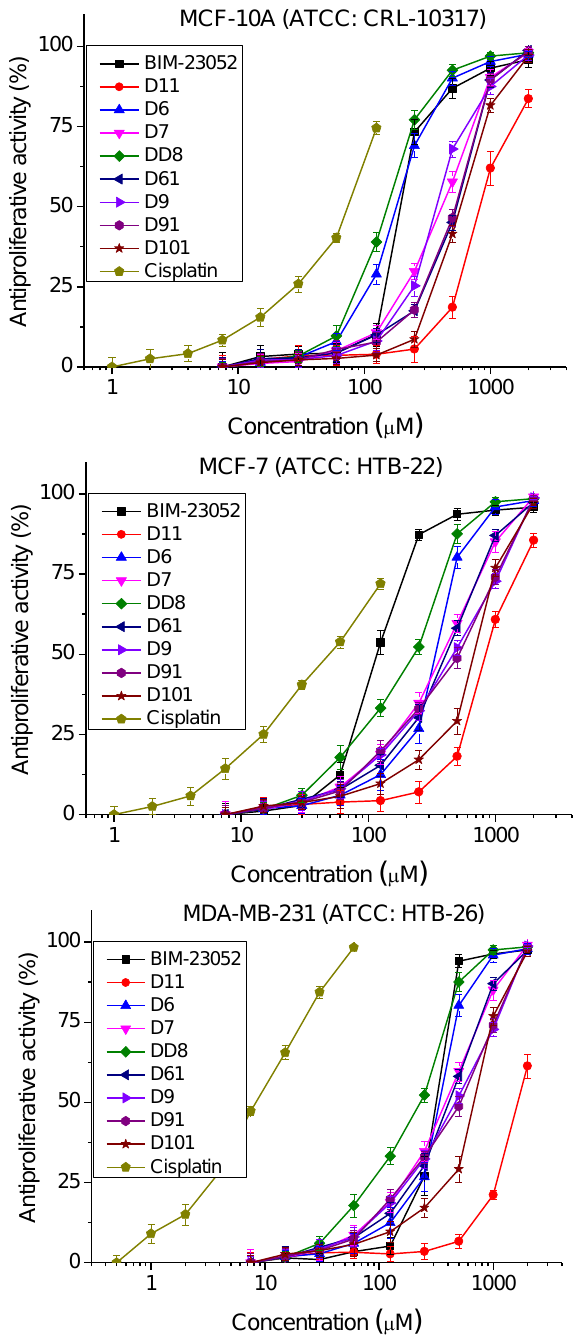
Figure 3. Dose–response curves for antiproliferative activity of BIM-23052 analogs determined in MCF-10A (ATCC ® CRL-10317 TM ), MCF-7 (ATCC ® HTB-22 TM ) and MDA-MB-231 (ATCC ® HTB-26 TM ) cell lines. Mean values are presented ± SD from three independent experiments, n = 6. Table 3. Cytotoxic and antiproliferative effects of the studied BIM-23052 analogs.